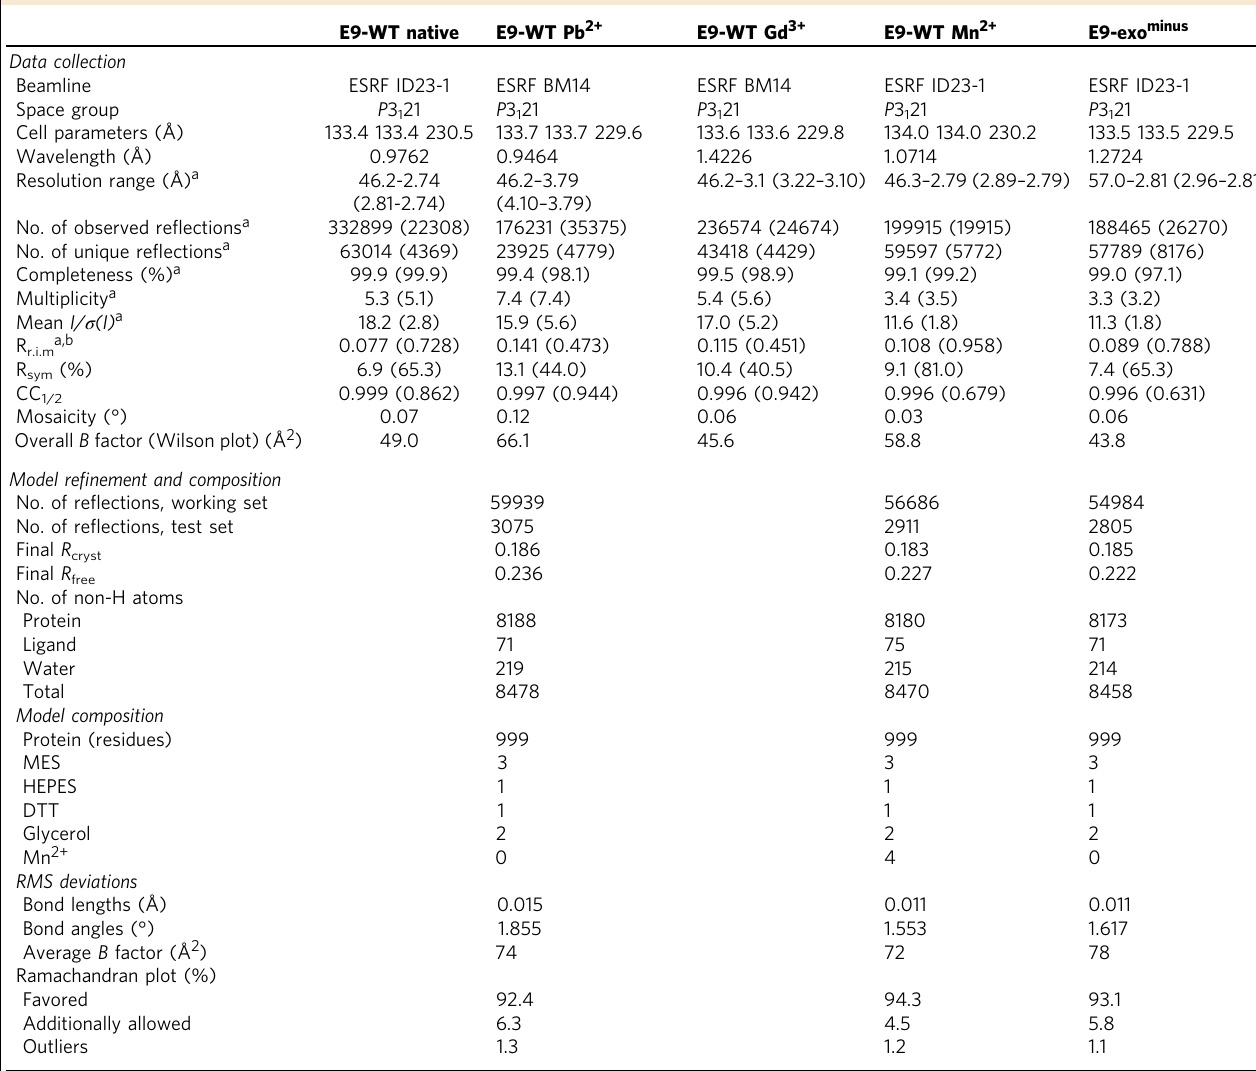
a Values in parentheses correspond to the highest-resolution shell b Estimated R r.i.m = R sym ×[ N /( N − 1)] 1/2 , where N is the data